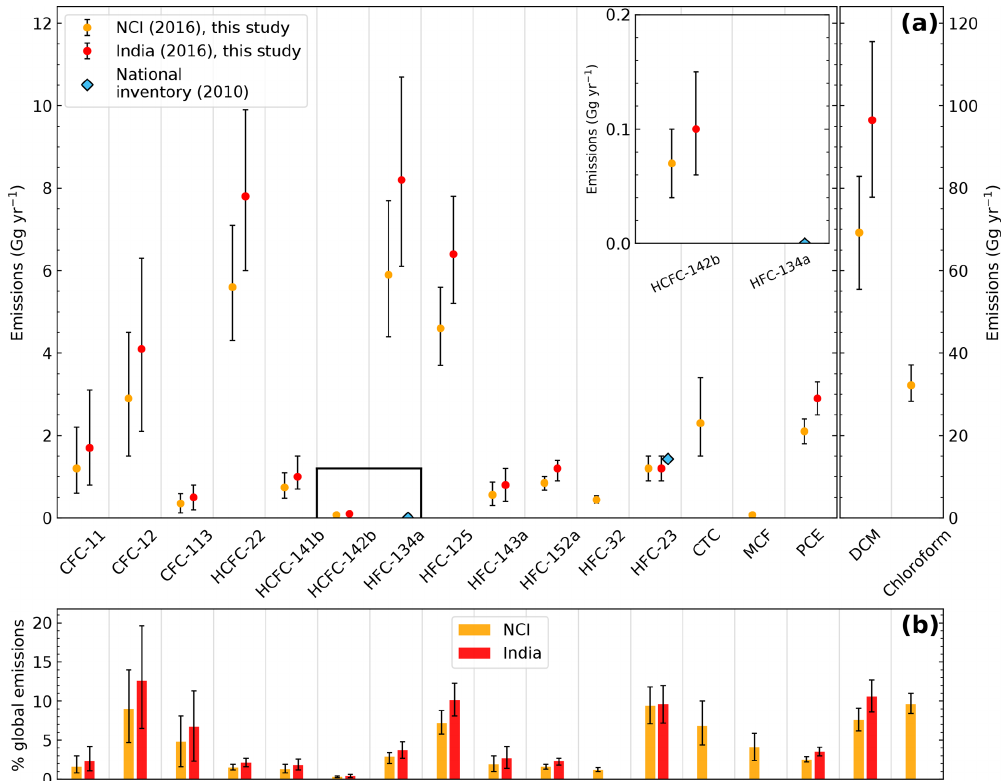
Figure 4. (a) NCI (orange) and India total (red) halocarbon emissions (Ggyr − 1 ) derived in this study. India’s most recent greenhouse gas inventory estimates (2010) are included where available. Note that emissions of DCM and chloroform are presented on a second y axis for clarity. (b) The estimated contribution of NCI and India to global halocarbon emissions (global estimates are an extension of the work by Rigby et al., 2014). Error bars represent the 5th–95th percentiles of the posterior